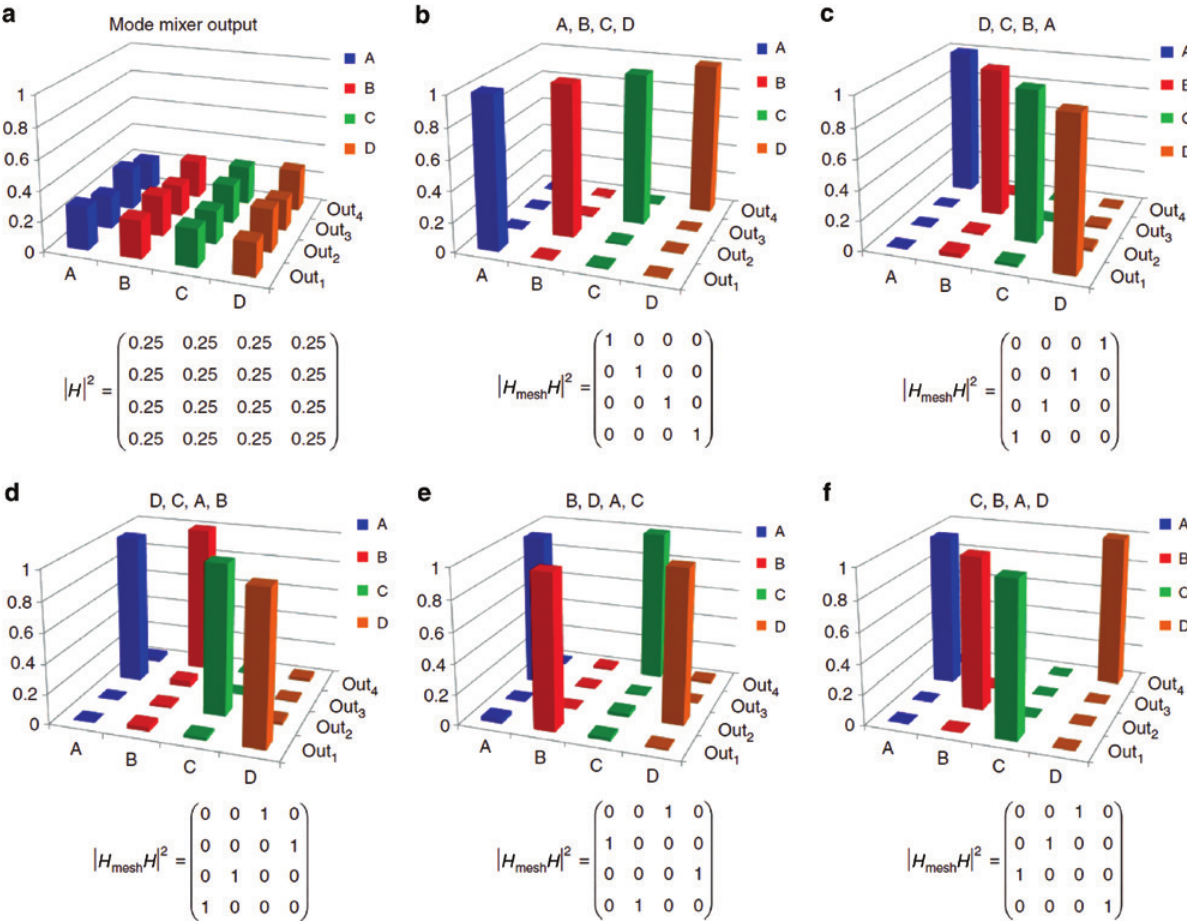
Figure 14: On-chip mode sorting operation of a 4 × 4 feedforward-only 4 × 4 chip reported in Ref. [18]. The mesh transmission matrix H can be configured in order to sort the reconstructed modes {A, B, C, D} arbitrarily at the output ports mesh {Out1, Out2, Out3, Out4} of the mesh after mode scrambling by mode mixer H , evenly spreading the power in the input waveguides of the